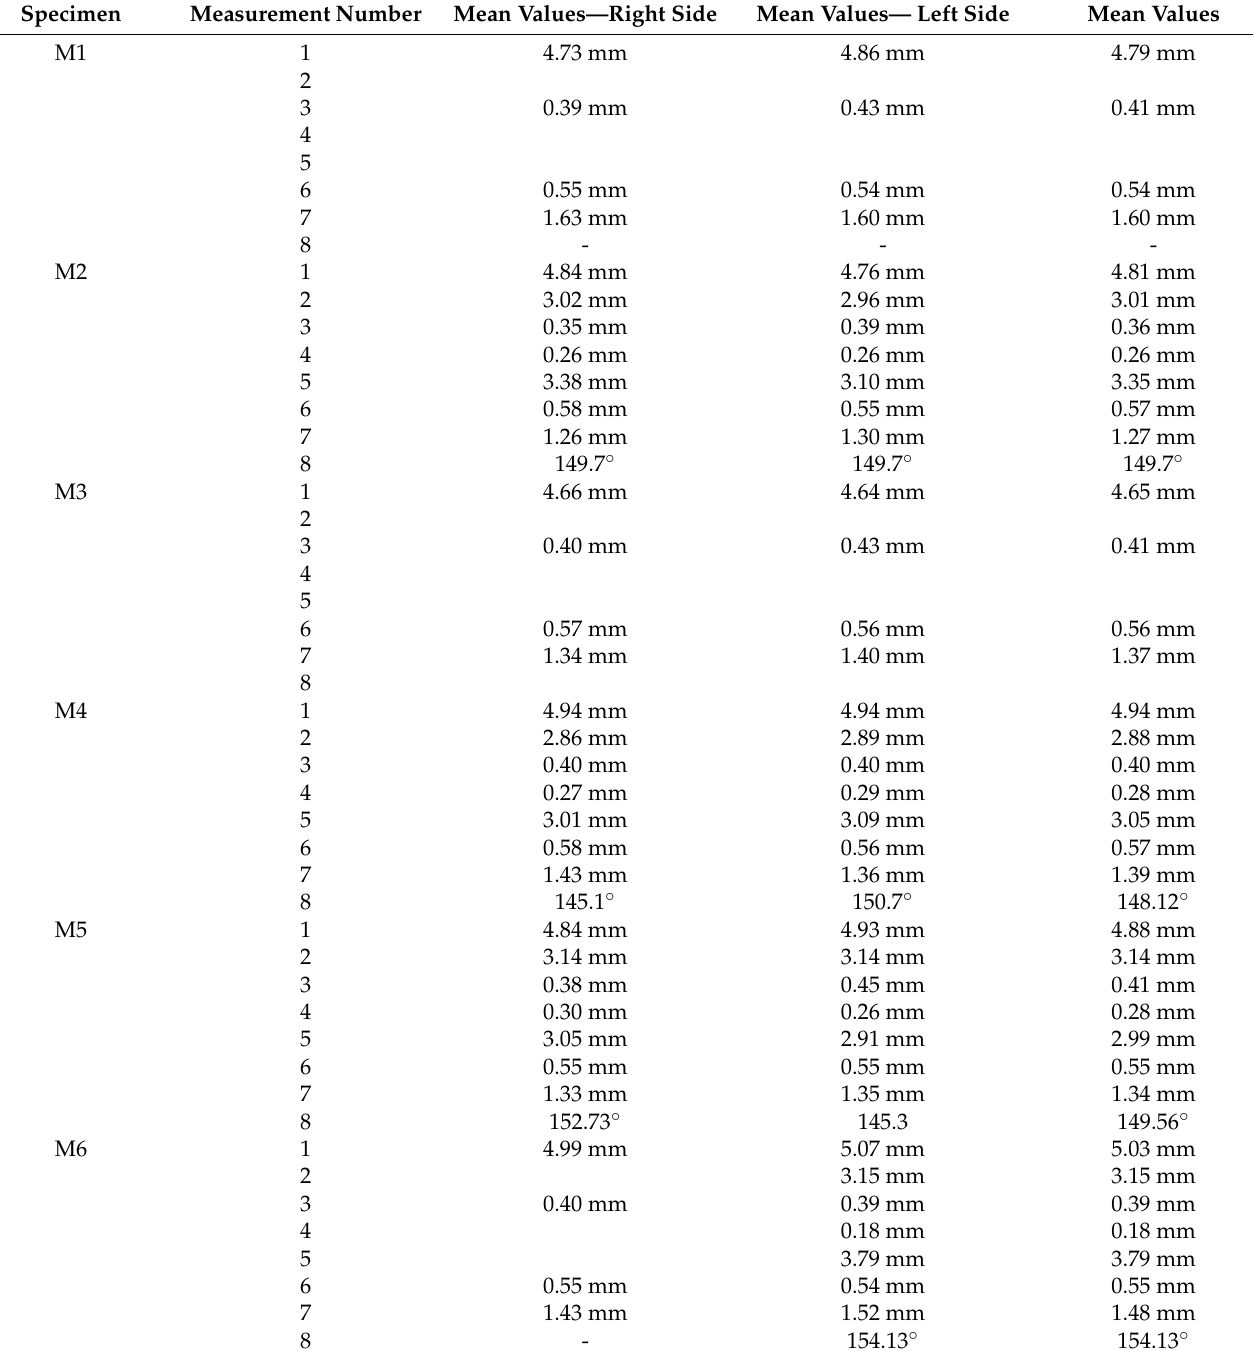
Table 6. Metric dimensions of the mallei in green monkey